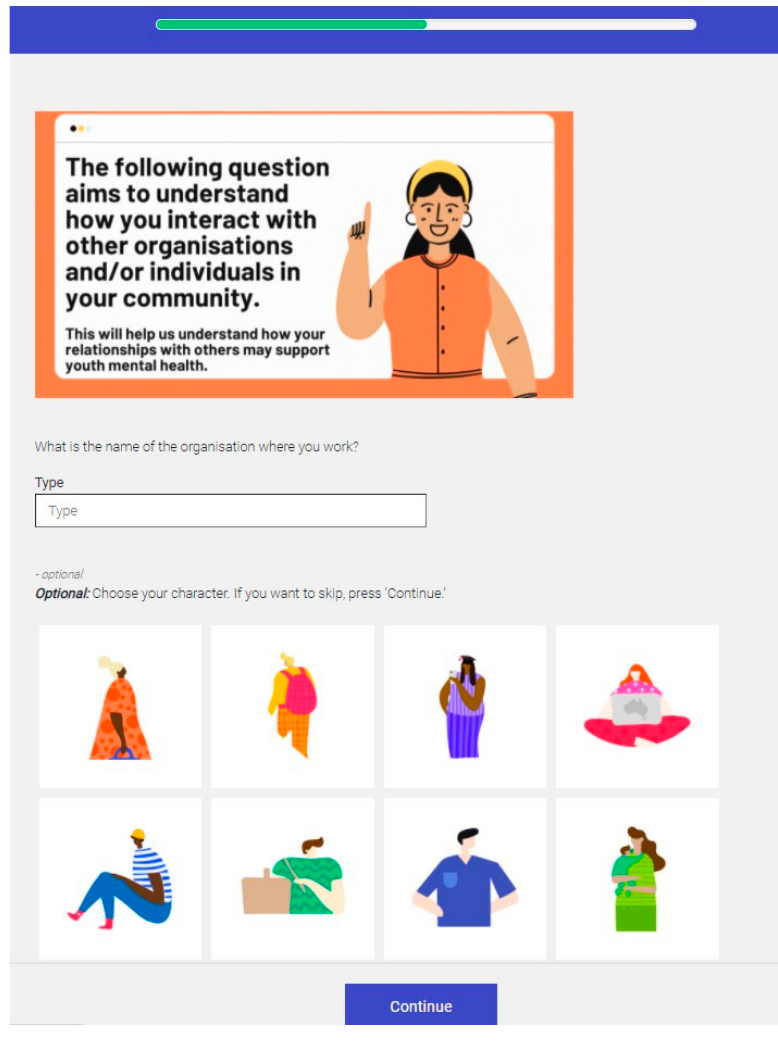
Figure 2. Preview of the gamified social network analysis activity to measure if interdisciplinary collaboration has changed (i.e., improved or been made worse) as a result of the PSM process.